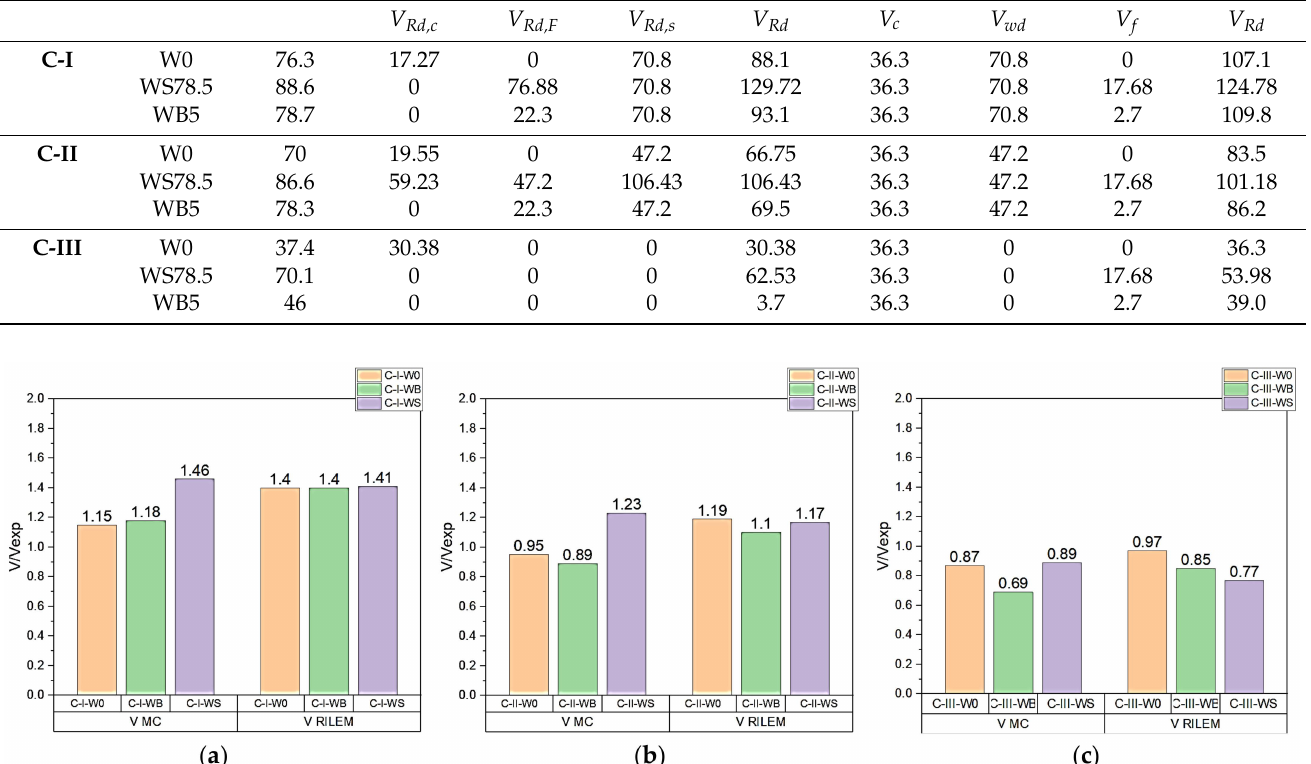
Figure 12. A comparison between experimental force V Exp [kN] and theoretical calculations performed pursuant to fib Model Code 2010 ( V MC ) and RILEM TC 162-TDF 2003 ( V RILEM ) for series: ( a ) C-I; ( b ) C-II; ( c )